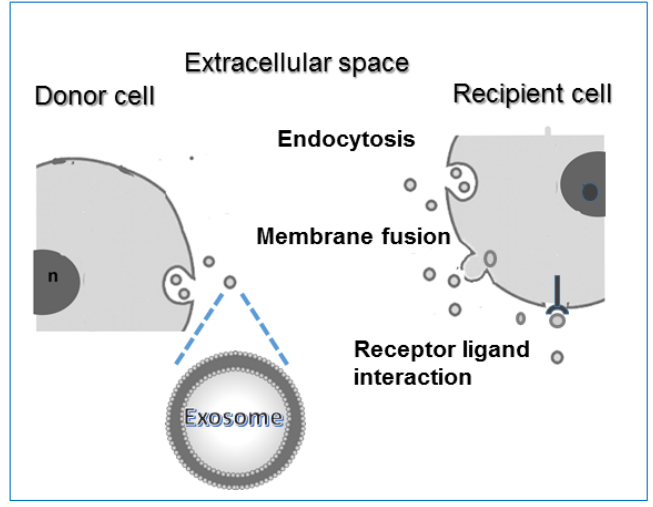
Figure 3. Schematic representation of the exosome uptake: exosomes released into the extracellular space from donor cell enter target cells in three ways, which are direct fusion with the plasma membrane, endocytosis, and protein–receptor interactions.